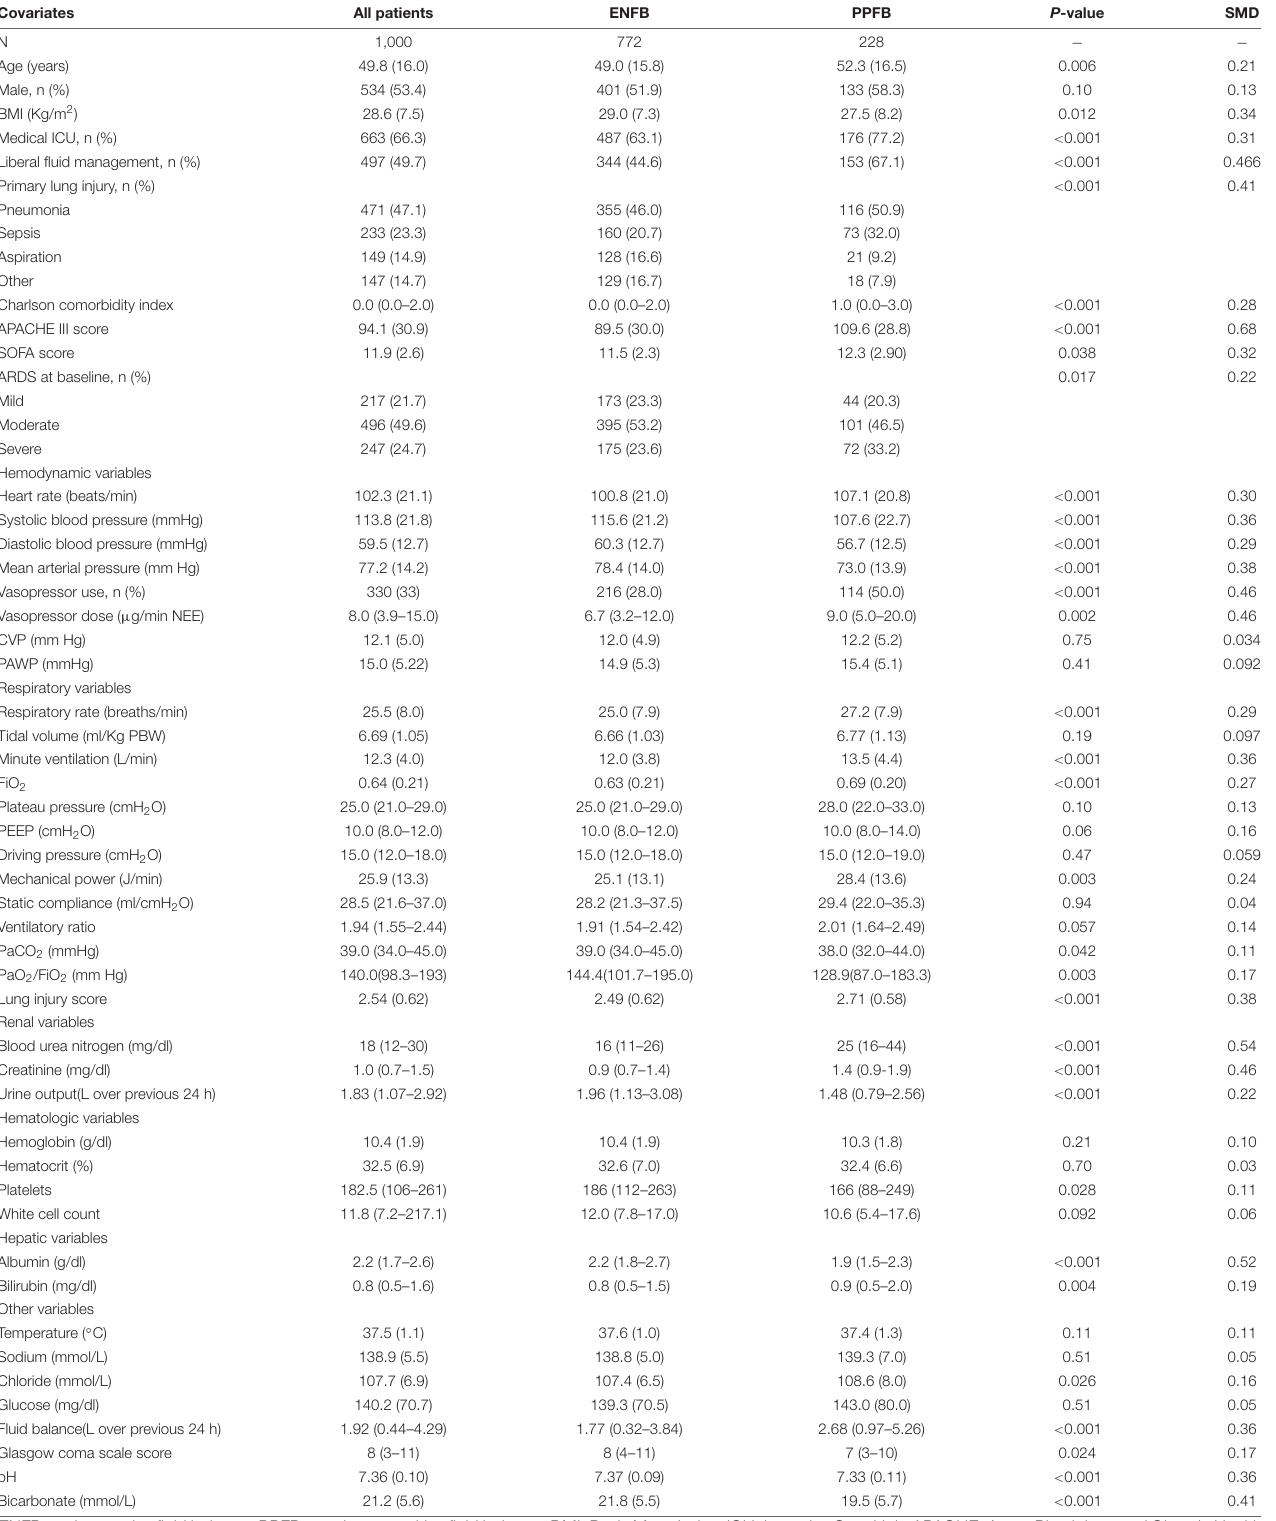
TABLE 1 | Comparisons of baseline characteristics between two phenotypes. Covariates All